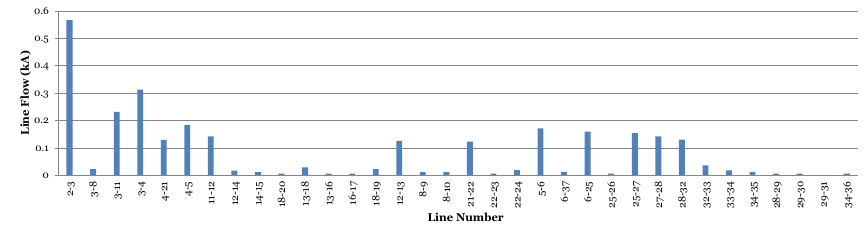
Figure 3. Line flows for 37 node system.